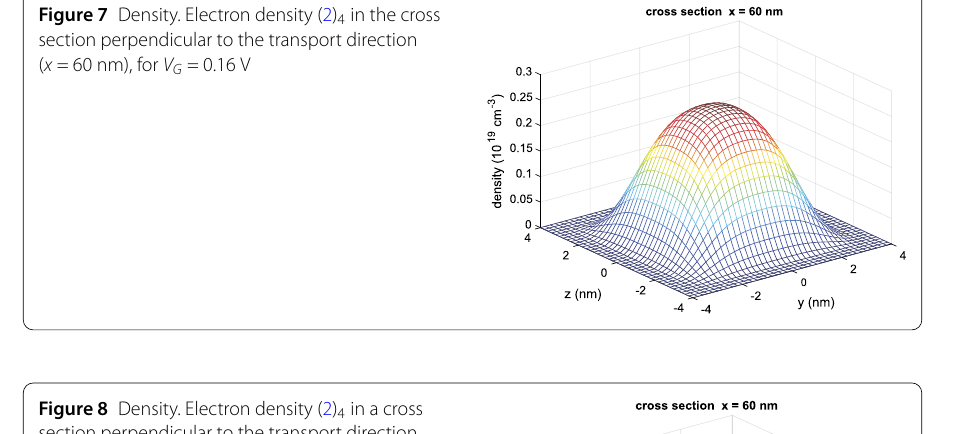
Figure 8 Density. Electron density (2) 4 in a cross section perpendicular to the transport direction ( x = 60 nm), for V G = 0.6 V